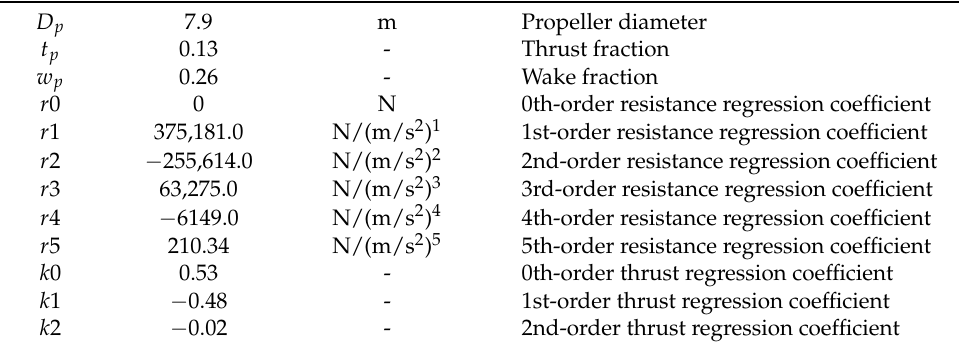
Table 25. Resistance and propulsion parameters of KCS container